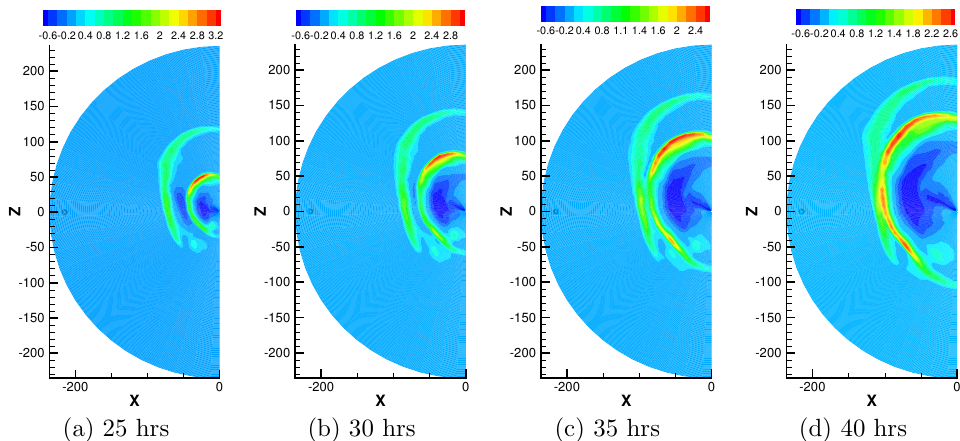
Figure 6. The contour plots of the relative density ( ρ − ρ wind ) / ρ wind distribution on the solar- terrestrial meridional plane after ( a ) 25 h ( b ) 30 h ( c ) 35 h and ( d ) 40 h of the first CME of CME23, where ρ is the total density and ρ wind is the density of the background solar wind.